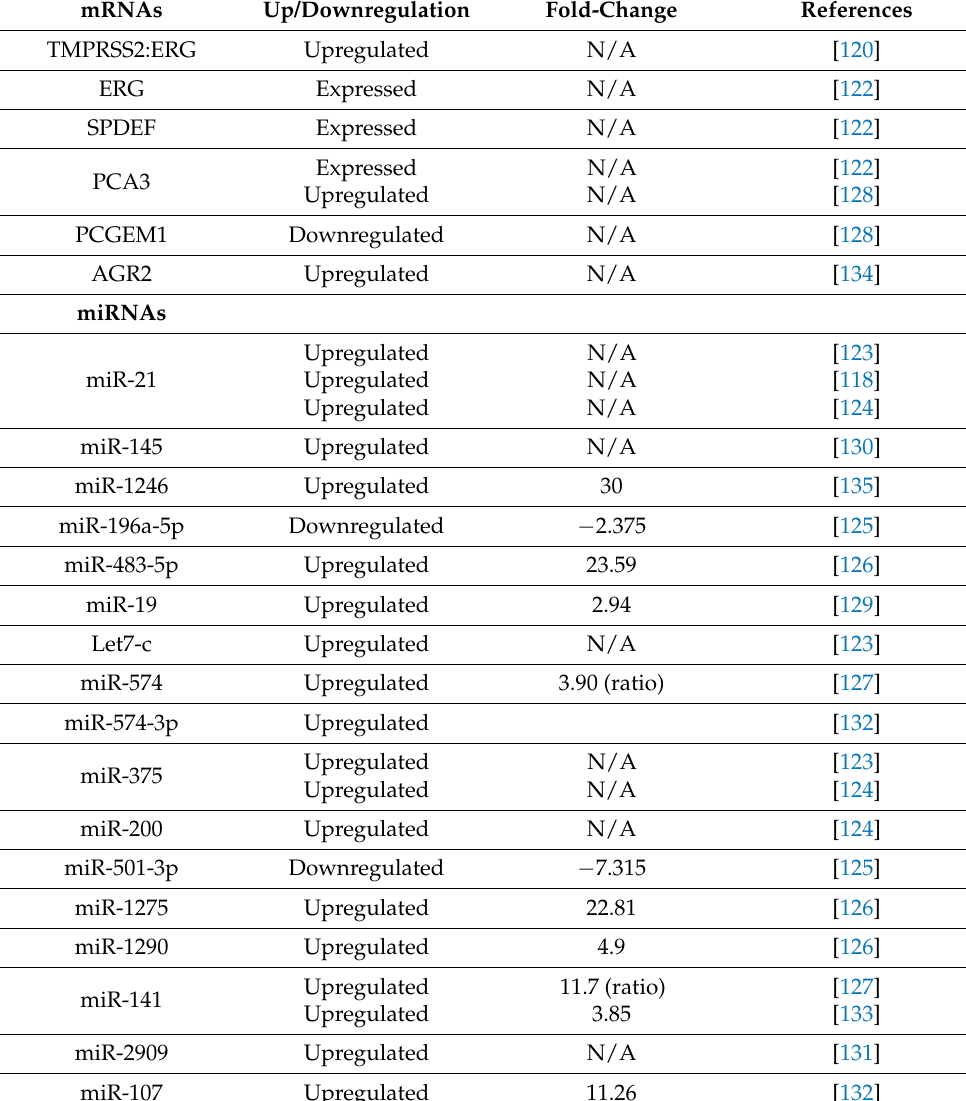
Table 5. EV-associated biomarkers of prostate